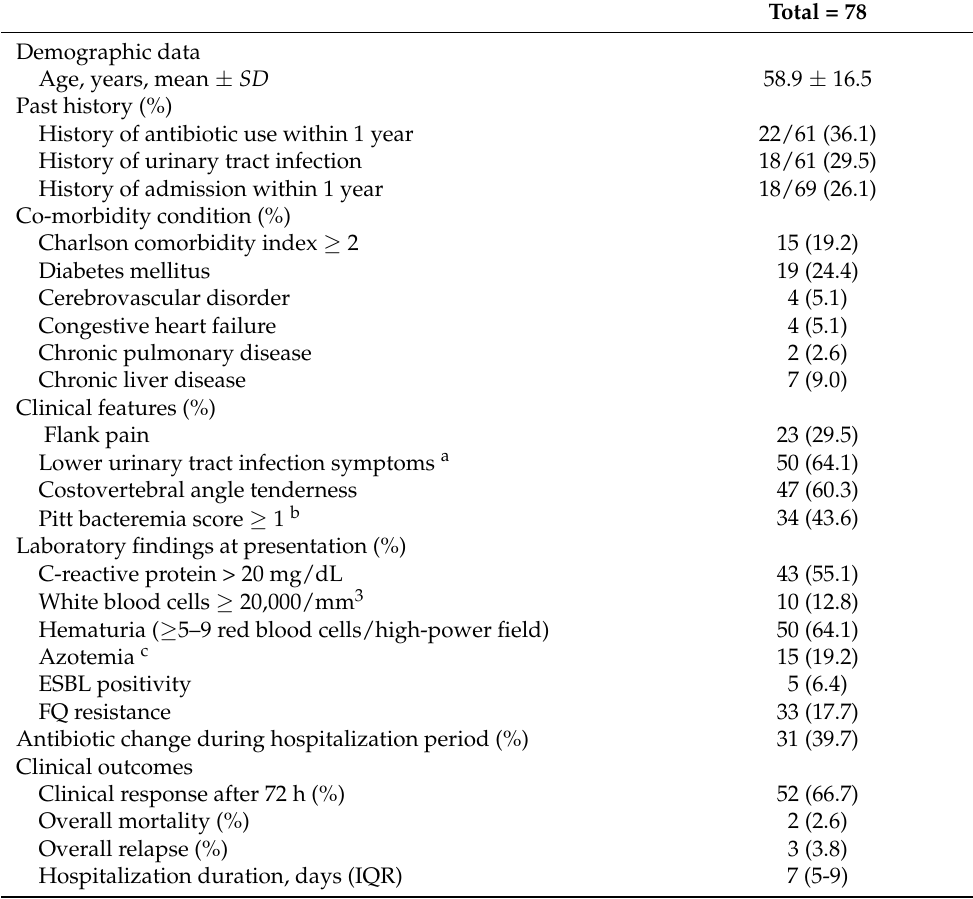
Table 1. Clinical characteristics and outcomes of the women with community-acquired acute pyelonephritis who used fluoroquinolone as empirical